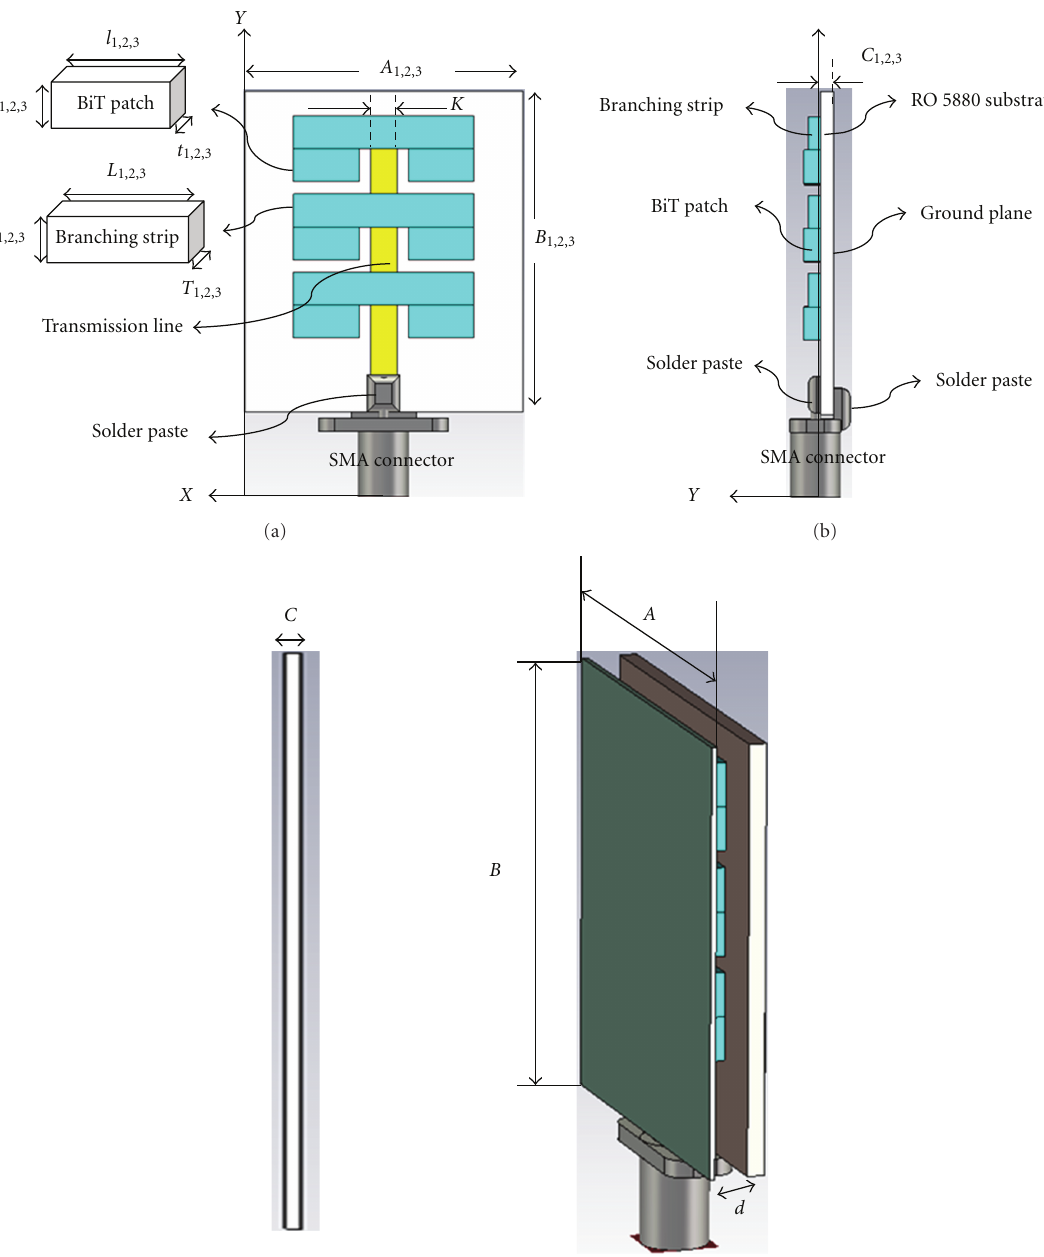
Figure 5: Geometry layout of proposed BiT array antenna (a) front (b) side views (c) stacked dielectric layer.